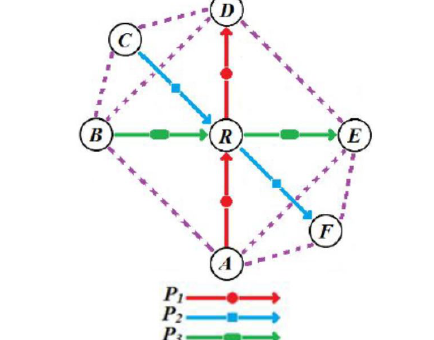
Fig. 2 . An example for jitter-based model